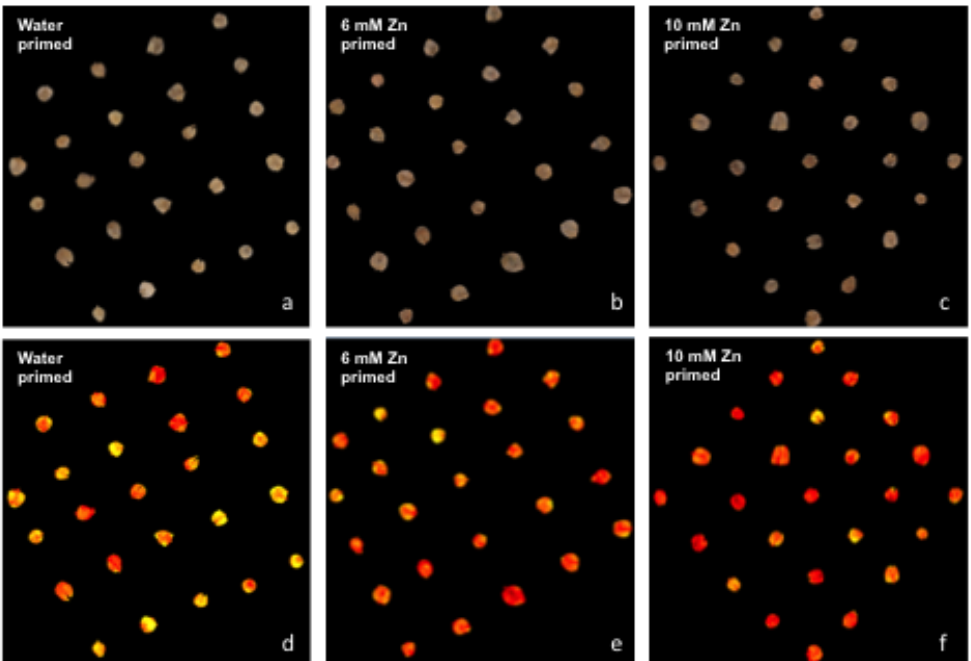
Figure 2. Visible spectrum images of 1,5-diphenyl thiocarbazone (DTZ)-stained water ( a ), 6 mM ( b ), and 10 mM ( c ) Zn-primed seeds. Images ( d – f ) (water-, 6 mM, and 10 mM Zn-primed seeds, respectively) taken with VideometerLab at wavelength 700 nm in hot view mode.